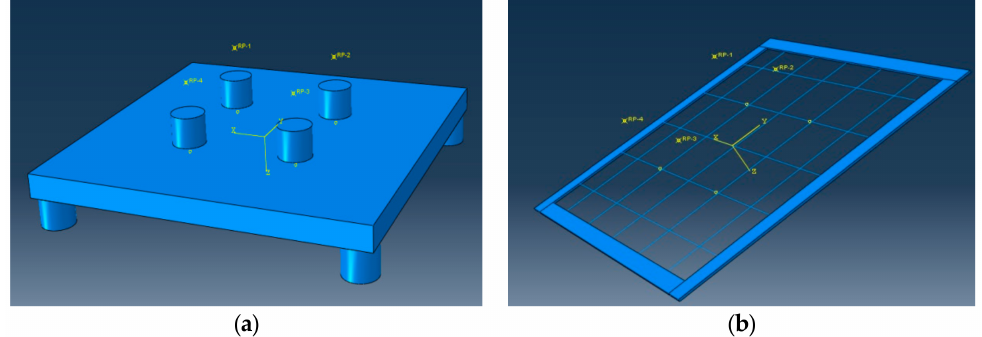
Figure 16. Finite element model. ( a ) Model parts; ( b ) Steel skeleton.